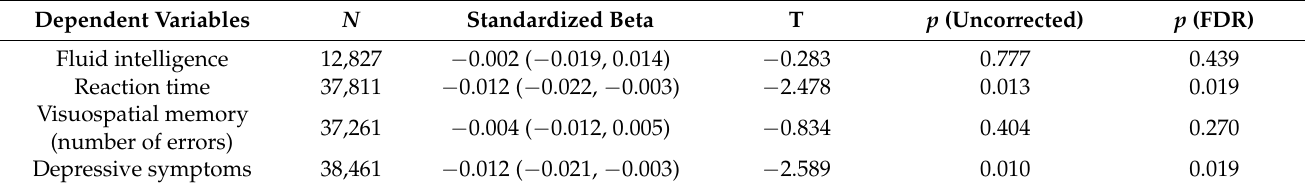
Figure 2. Associations of baseline diastolic BP with subsequent changes in cognitive measures. Bars represent raw unadjusted pre- and post-test values and error bars represent the standard error of the mean. ( a ) Reaction time (RT). ( b ) Depression score. Multiple regression analyses adjusting for confounding variables revealed that greater diastolic BP was associated with a smaller increase in reaction time (smaller decline in cognitive speed) and reduce depressive tendency after adjusting for potential confounding variables, including baseline outcome measures ( p < 0.05, corrected for FDR). Table 1. Associations between baseline diastolic blood pressure and longitudinal changes in psycho- logical measures revealed by multiple regression analyses.